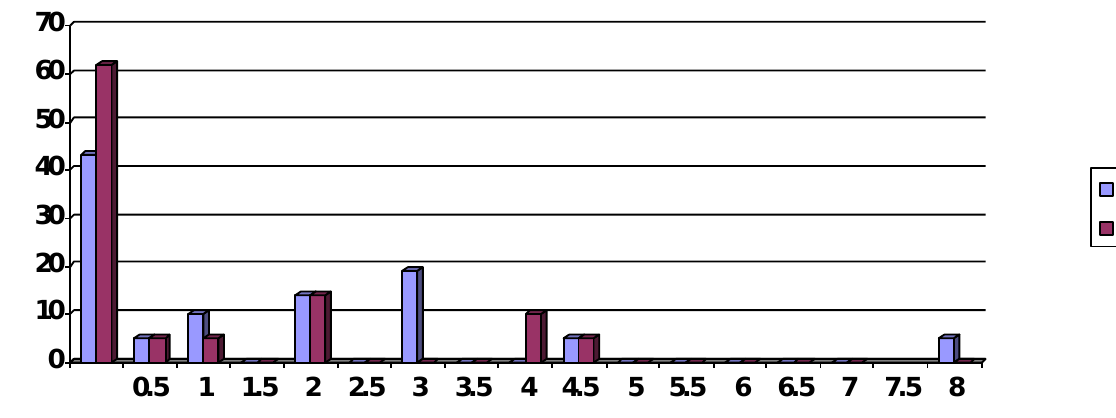
Fig. 3. Quantity of hours in free time, spent for intensive or moderate physical activity: t – hours; D – no physical activity; I – intensive; U – moderate.